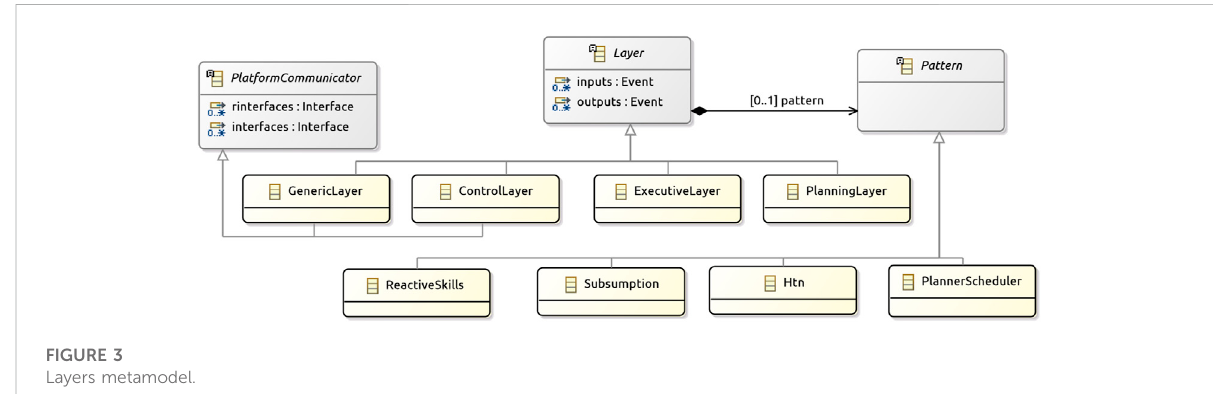
FIGURE 3 Layers metamodel.